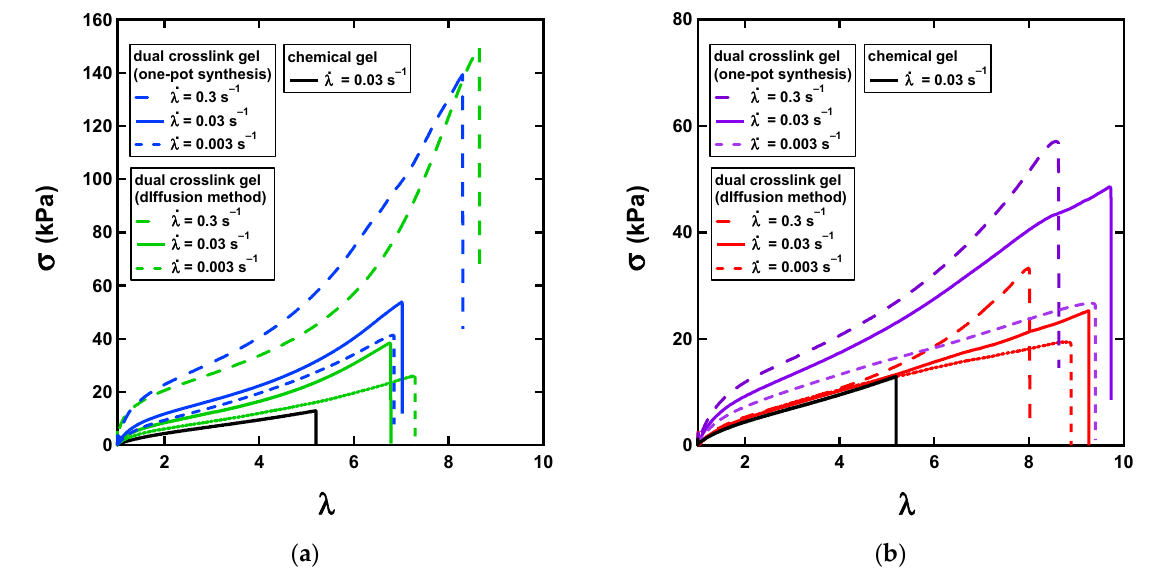
Figure 9. ( a ) Stress–stretch curves for uniaxial tensile tests for the chemical gel (black), and P(AAm- co -VIm)-Ni 2+ dual- crosslink gels prepared by the one-pot synthesis (blue) and by the diffusion method (green). ( b ) Stress–stretch curves for uniaxial tensile tests for the chemical gel (black), and P(AAm- co -VIm)-Zn 2+ dual-crosslink gels prepared by the one-pot synthesis (purple) and by the diffusion method. Dual-crosslink gel (red).